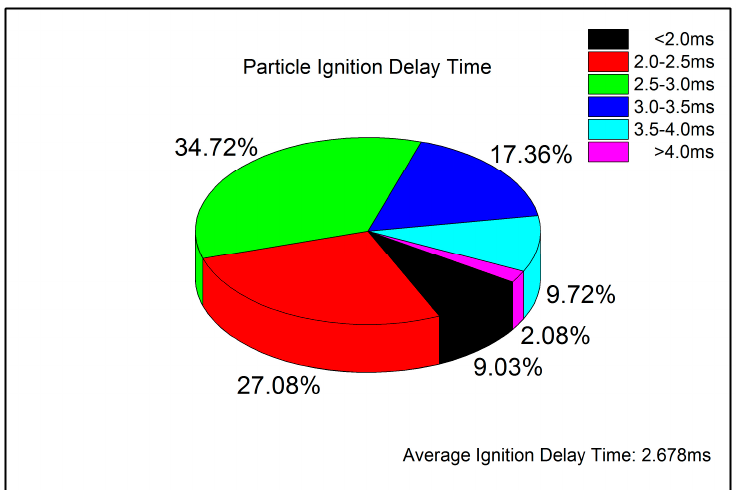
Figure 9. Ignition delay time distribution of Al particles.